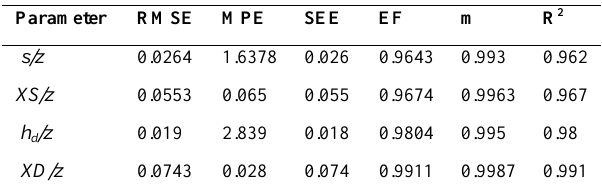
Table 2. Error functions from results suggested by equations (11)-(14) against experimental